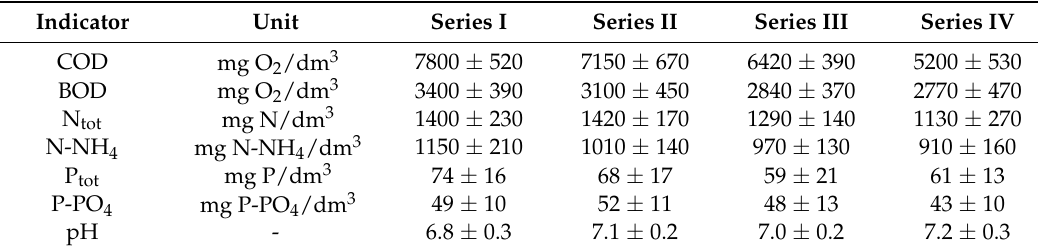
Table 1. Values of the basic indicators of the anaerobic digestion effluents (ADE) used in the experiments.